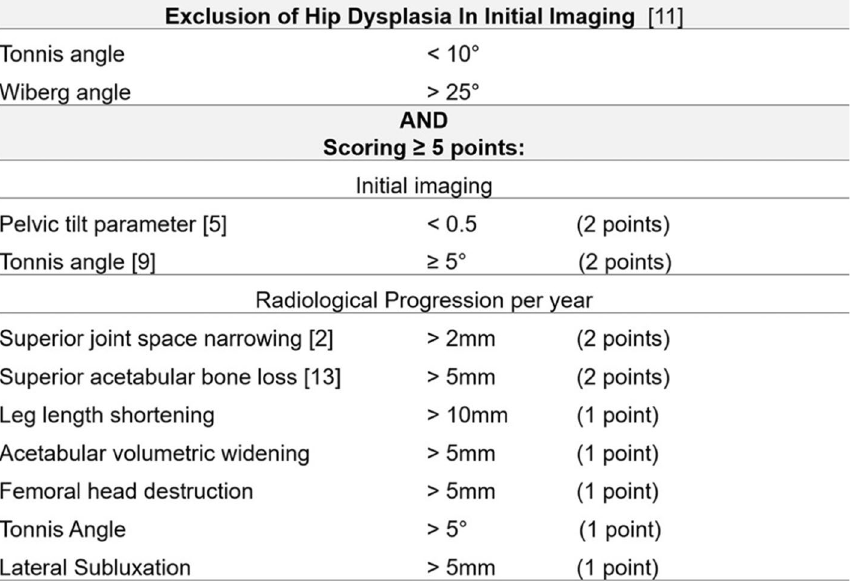
Table 2 Clinical and radiological features of rapidly progressive osteoarthritis of 81 hips. Values are represented as mean